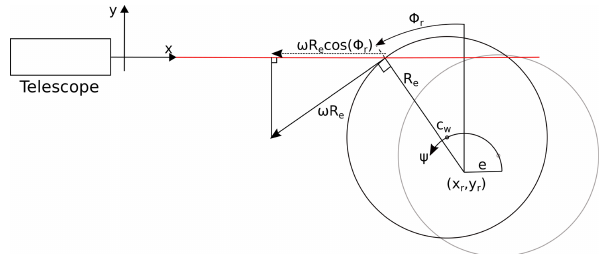
Figure 6. Schematic drawing of the influence of the wheel not ro- tating around its centre point. The wheel rotates around the point ( x r ,y r ) which is offset from the wheel centre, c w , by e